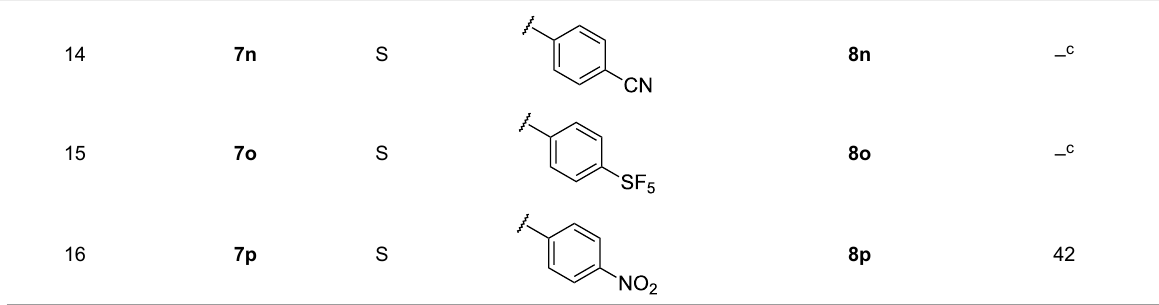
Table 1: Examination of N , S -acetals substituted with a heterocycle ( 7aa–k ) or an arene ( 7l–p ). (continued)